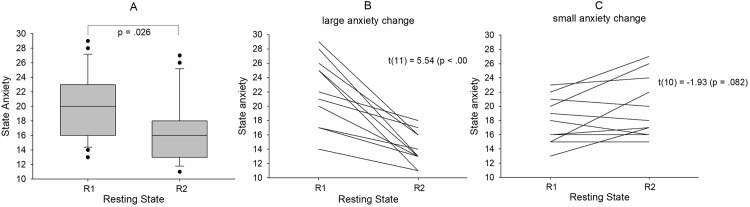
Boxplot depicting the distribution of state anxiety across the resting states R1 and R2 for all 23 subjects (A). Note: whiskers indicate the 10th and 90th percentile. Examples of strong anxiety decline (large anxiety change) in a group of 12 subjects (B) and weak anxiety decline or anxiety increase (small anxiety change) in a group of 11 subjects (C).